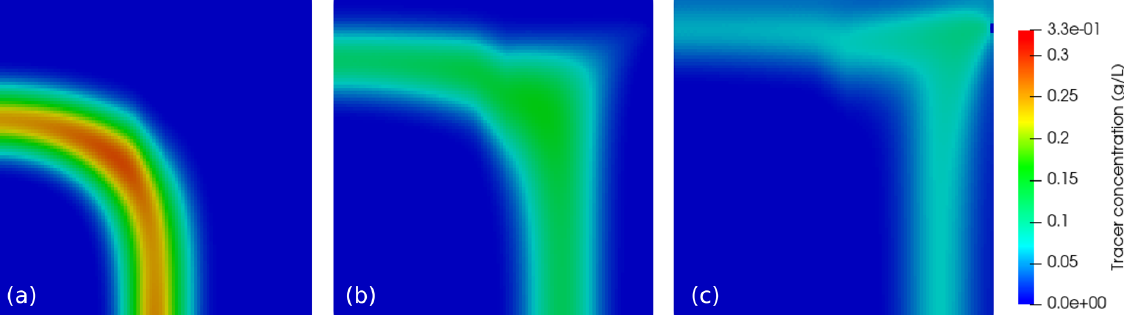
Figure 3. Spatial distribution of tracer concentration calculated with TRANSPORTSE-PHREEQC for simulation times (a) 8h, (b) 16h, and (c) 24h for Case 1 using the same scale mapping as in Poonoosamy et al. (2021, Fig. 3).